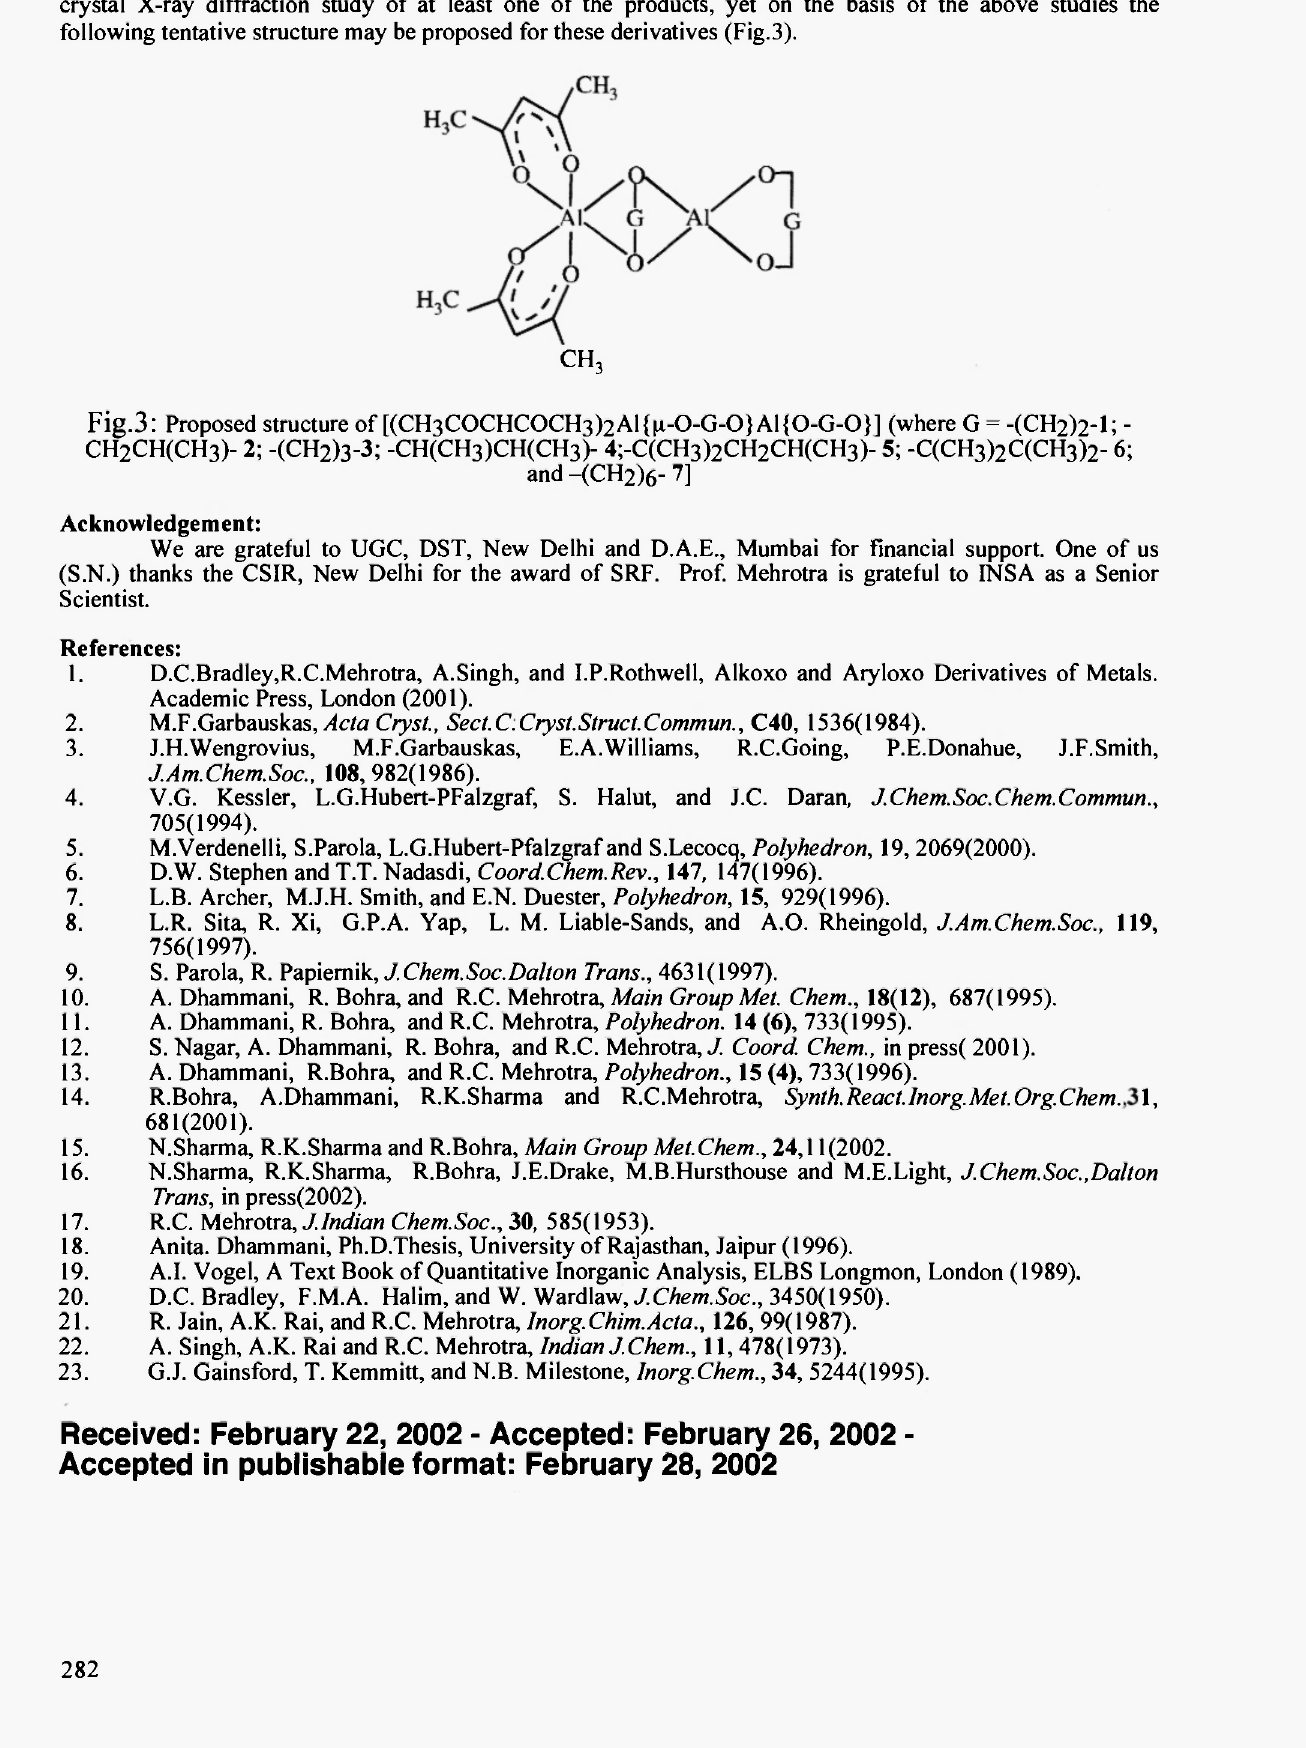
Fig.3: Proposed structure of [(CH3C0CHC0CH3)2Al^-0-G-0}Al{0-G-0}] (where G = -(CH2>2-1; -